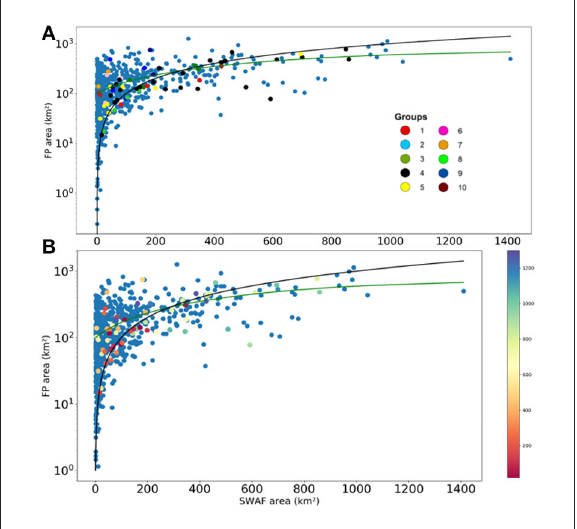
FIGURE11 Relationship between the floodplain areas of the DEM delineation and the SWAF-HR estimation for each sub-basin. The index represents the location of the sub-basin in the watershed. A low index refers to a sub-basin located near